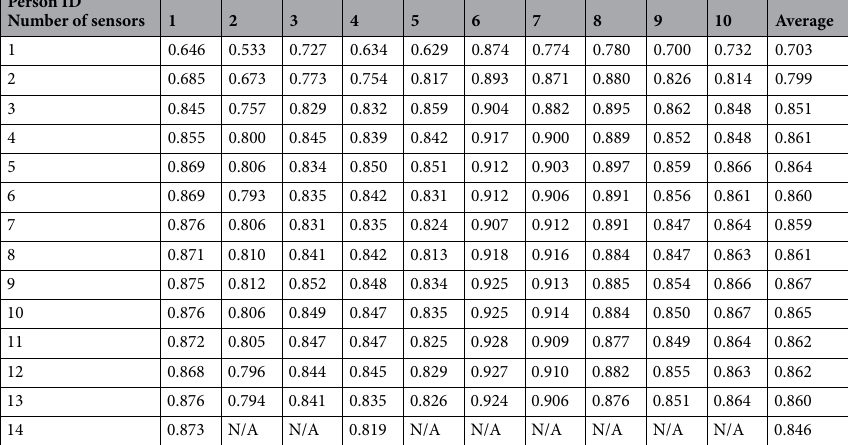
Person ID Number of sensors